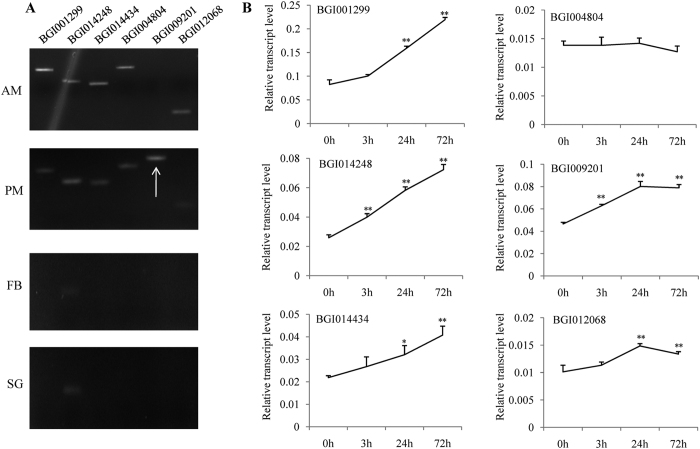
Analysis of induced MG-specific genes with transmembrane transport function.BGI001299, BGI014248, BGI014434, BGI004804, BGI009201, and BGI012068 were detected. (A) RT-PCR with AM, PM, FB, and SG. (B) qPCR with MG 0 h, MG 3 h, MG 24 h, and MG 72 h. Bars, standard deviations. Statistically significant differences: *P < 0.05, **P < 0.01.